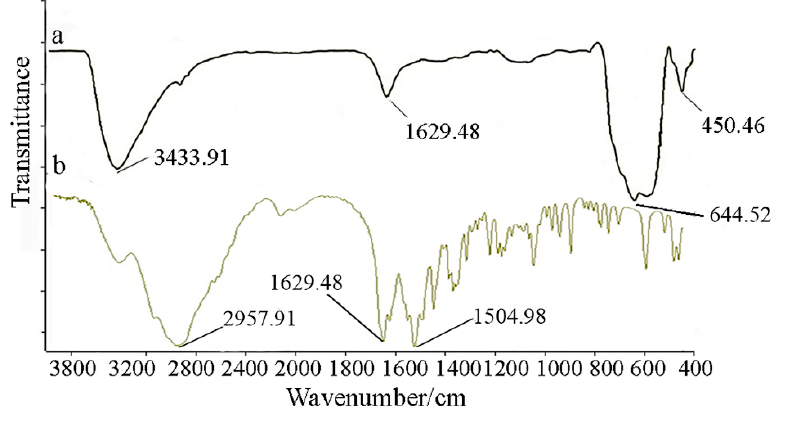
Figure 2. Fourier transform infrared spectroscopy (FTIR) spectra of ( a ) L -lysine coated magnetite nanoparticles and ( b ) pure L -lysine.